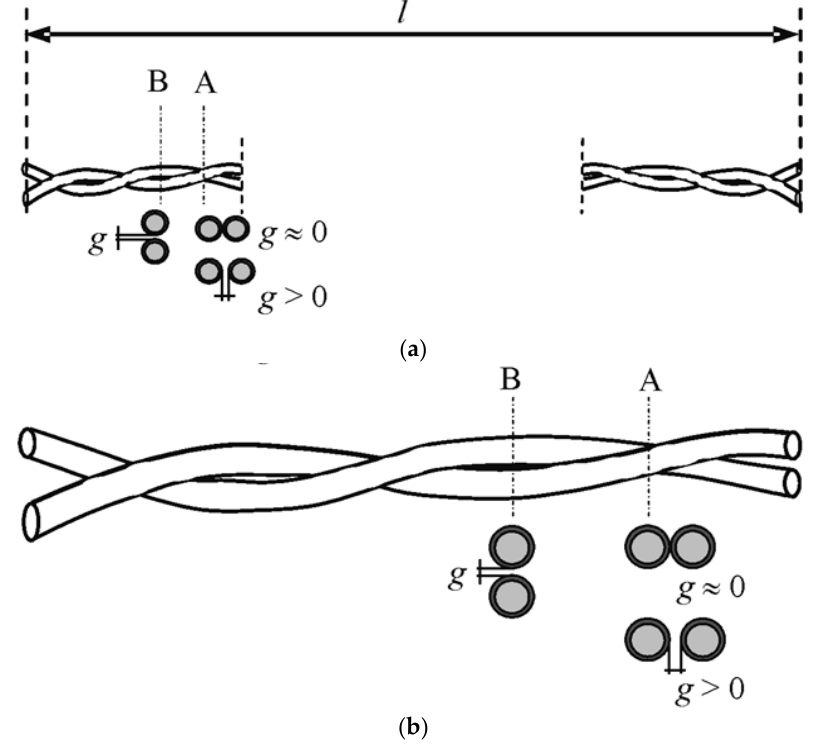
Figure 4. Part of twisted-pair (TP) sample: ( a ) small diameter wires; ( b ) large diameter wires; g—distance between wires in cross section A or B.